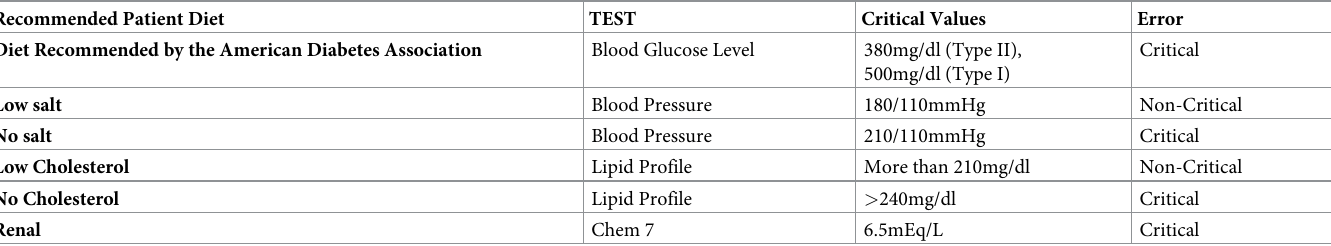
Table 2. Classification of dietary errors as per biochemical reports after wrong meal consumption according to hospital’s criteria. Recommended Patient